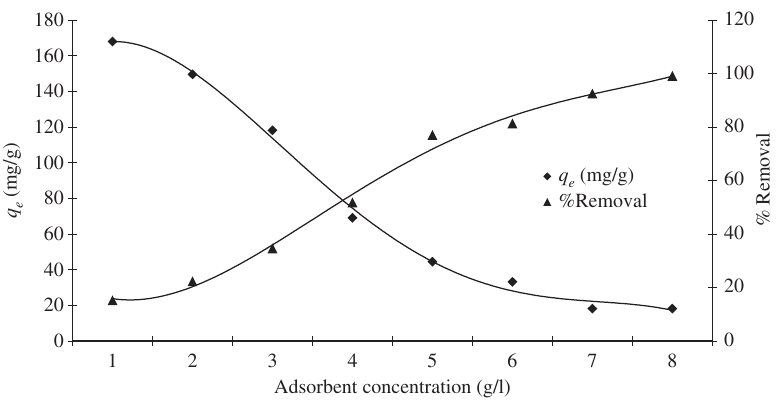
Figure 2: Effect of sample dose on both adsorption capacity and % removal of Pb(II) onto S. sesban L. at 30 ° C. [Adsorption conditions employed: Pb(II) ion concentration, 300 mg/l; pH, 4.5; agitation time, 2 h; adsorption temperature, 30 ° C; particle size, 50–150 μ m.]